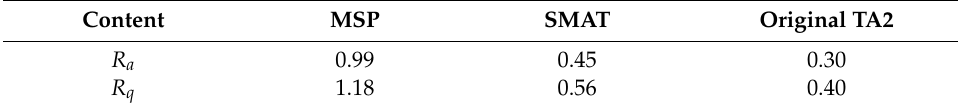
Figure 6. The surface 3D morphologies of three kinds of specimens: ( a ) original TA2, ( b ) 90 min SMAT specimen, and ( c ) 30 min MSP specimen. Table 2. Surface roughness of three kinds of specimens.